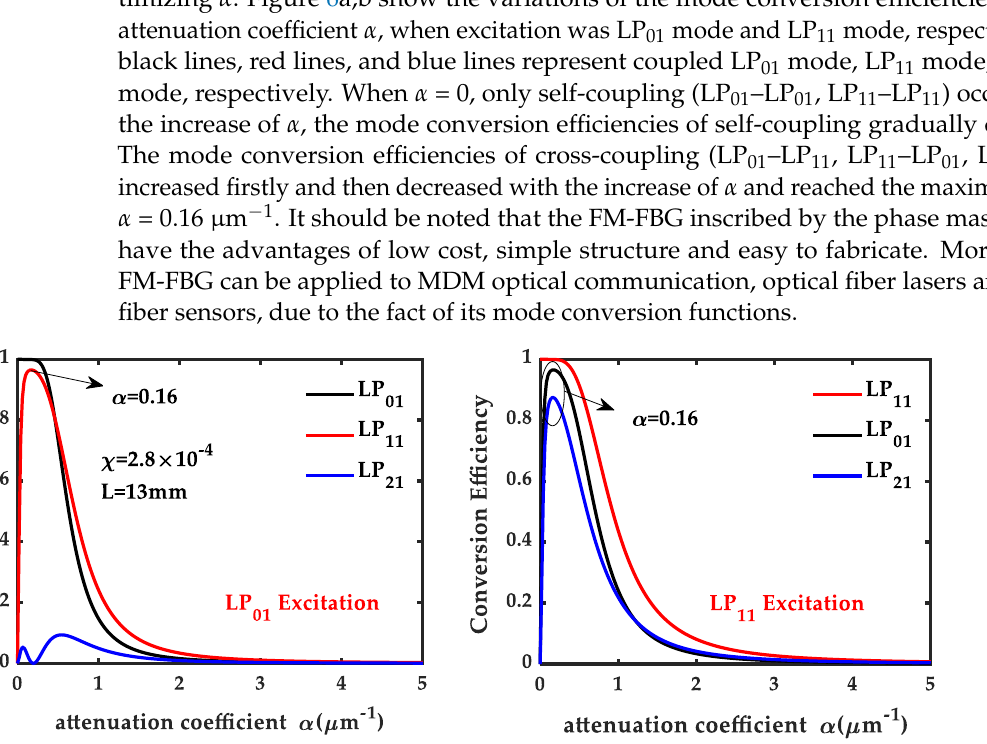
01 mode and ( b ) LP 11